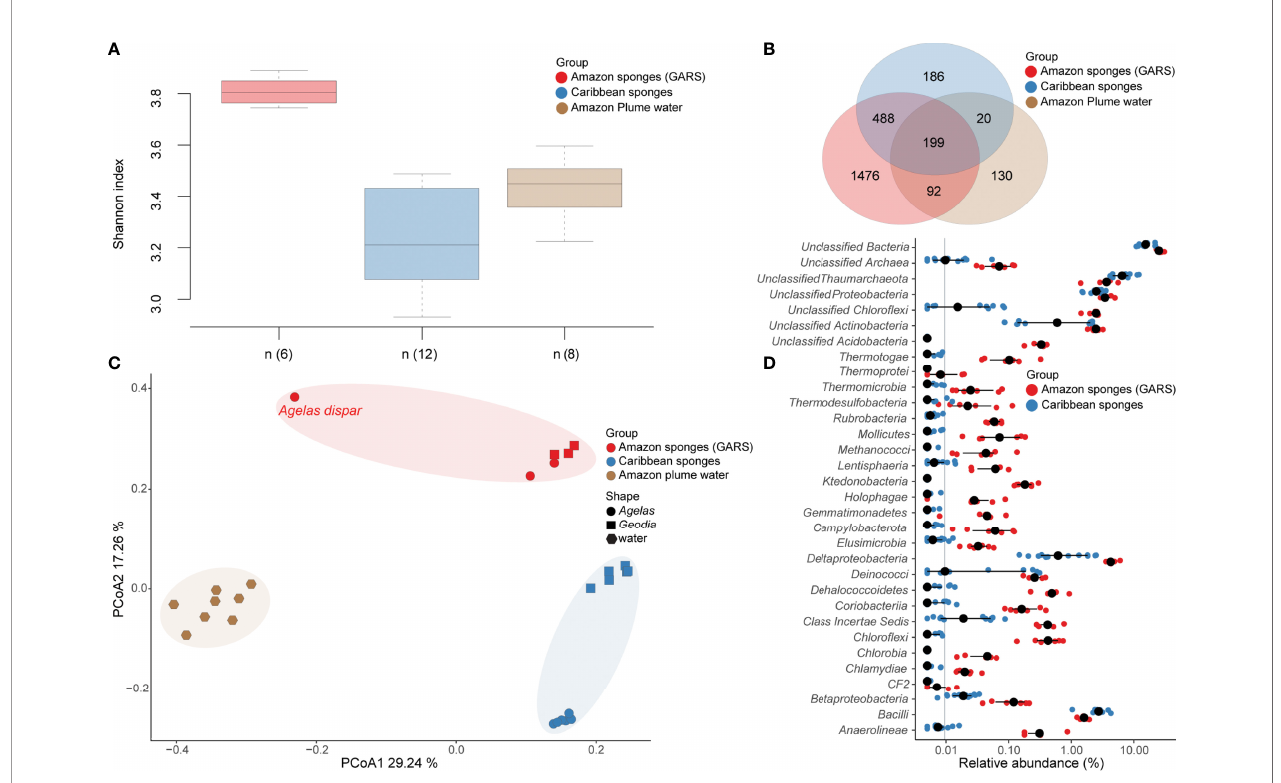
FIGURE 2 | Microbiome composition comparison between GARS sponges Caribbean sponges and Amazon plume water samples. (A) Shannon Alpha diversity variation in sponge ’ s microbiome from the GARS (red) and the Caribbean (blue), as well as the Amazon plume water (brown) microbiome (Kruskal-Wallis test, chi- squared = 16.328, df = 2, P < 0.001). The (n) represents the number of samples in each box plot. Wilcoxon pairwise comparisons show that all groups tested were statistically different (P < 0.05). (B) Venn diagram of microbiome taxa that are unique or shared between sponges from the GARS (red) and the Caribbean (blue), as well as the Amazon plume water microbiome (brown). (C) Beta diversity of microbiomes associated with Agelas and Geodia sponges from the GARS (red) and the Caribbean (blue), as well as the Amazon plume water microbiome (brown) by principal coordinate analysis (PCoA) of Bray – Curtis dissimilarity (R 2 = 0.43 P=0.0001). Each point represents a microbiome sample, Agelas are represented by circles, Geodia by rectangles, and water samples by hexagons. (D) Microbiome class level relative abundance differences between GARS and Caribbean sponges. GARS sponge ’ s microbiome is shown by red circles, while Caribbean sponges microbiome is shown by blue circles. Black circles are the median relative abundance for a speci fi c taxa to the class